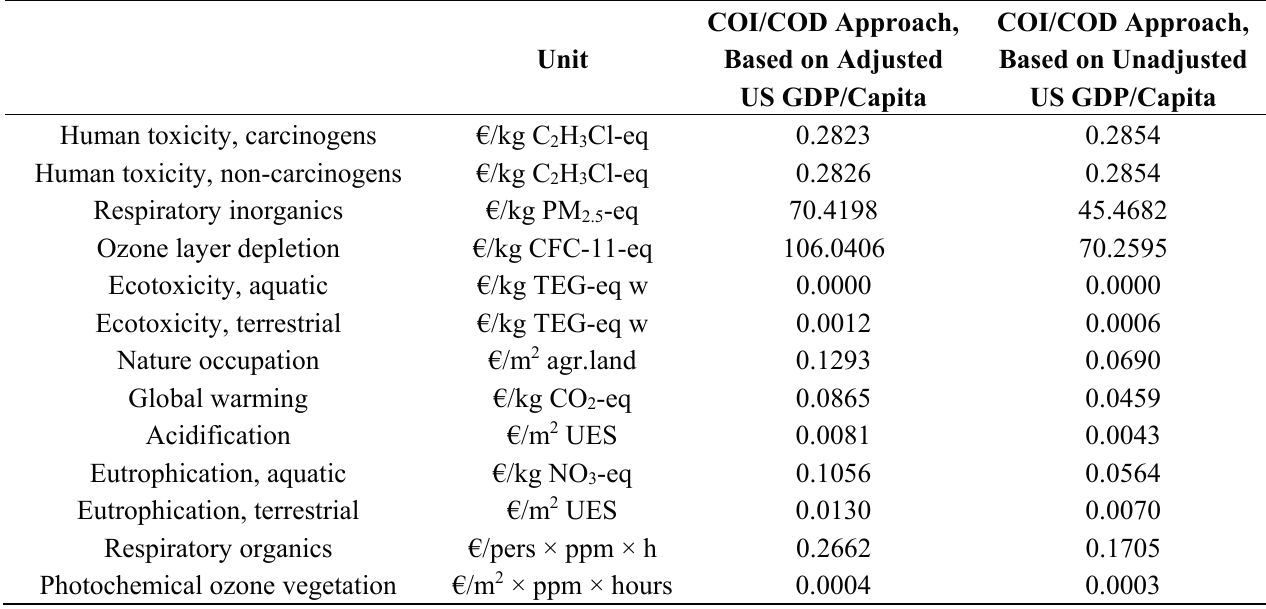
Table S2. Monetized environmental effects (2010 price level).